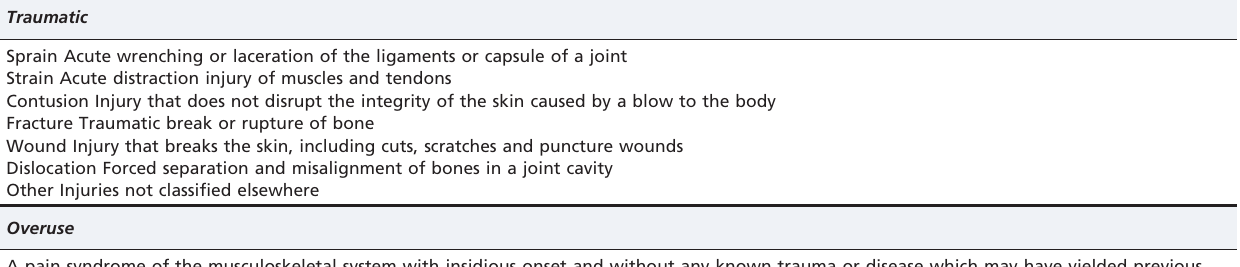
Table 5 - Classification of injury